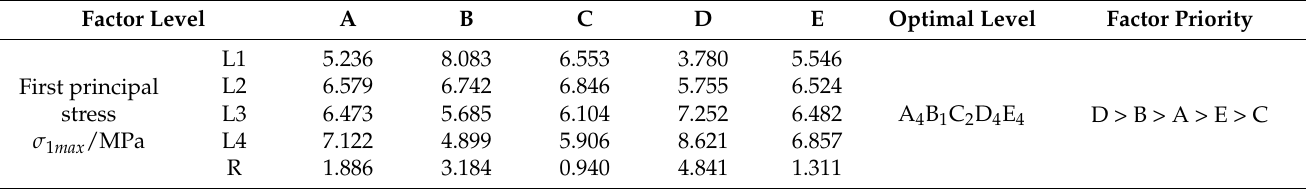
Table 4. Analysis of the degree of influence of various factors on the major principal stress σ 1 [23].